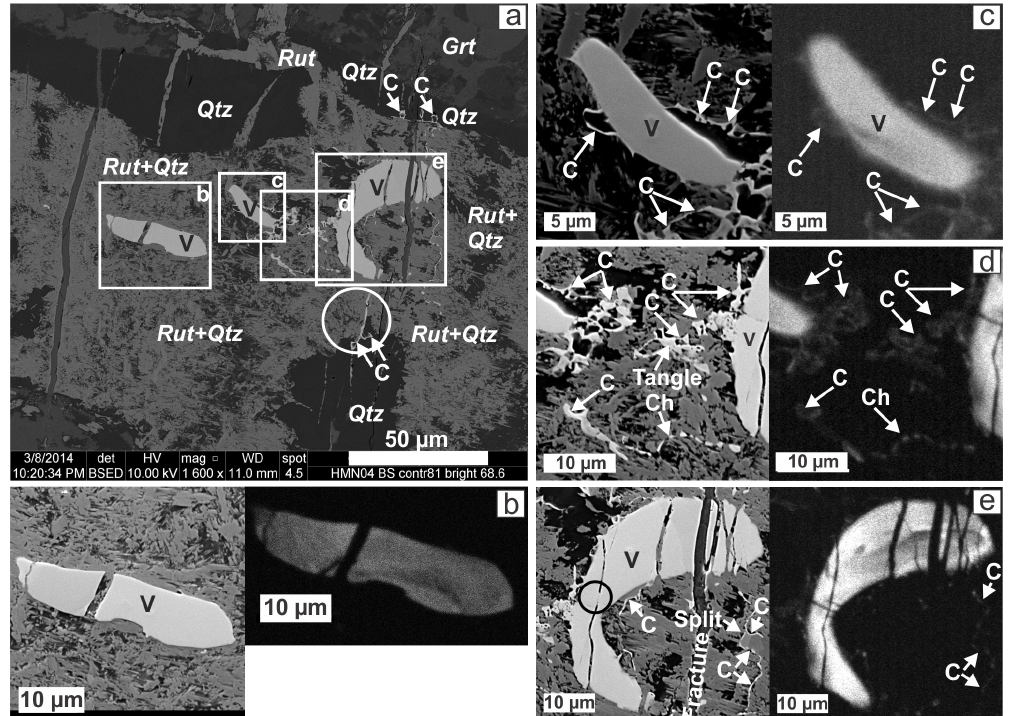
Figure 3. (a) BSE image of the vermicular-shaped zircon aggregates (“V”) and zircon coronae (“C”). Arrows indicate zircon coronae that trace the quartz–rutile boundary or fill the cavities in quartz; the circle highlights a corona that fills the fracture. Mineral abbreviations as in Fig. 1. (c–e) Enlarged BSE (left) and CL (right) images of the areas indicated in panel (a) . V highlights the vermicular-shaped zircon grains and C points to zircon coronae (the difference between V and C is in thickness). “Ch” in panel (d) points to the chain of submicron-sized zircon grains, and “Tangle” points to the tangled occurrence of coronae. Arrows in panel (e) indicate the directions of the reaction fronts, and “Split” points to the branching of zircon coronae. The circle in panel (e) highlights a partially healed fracture in vermicular